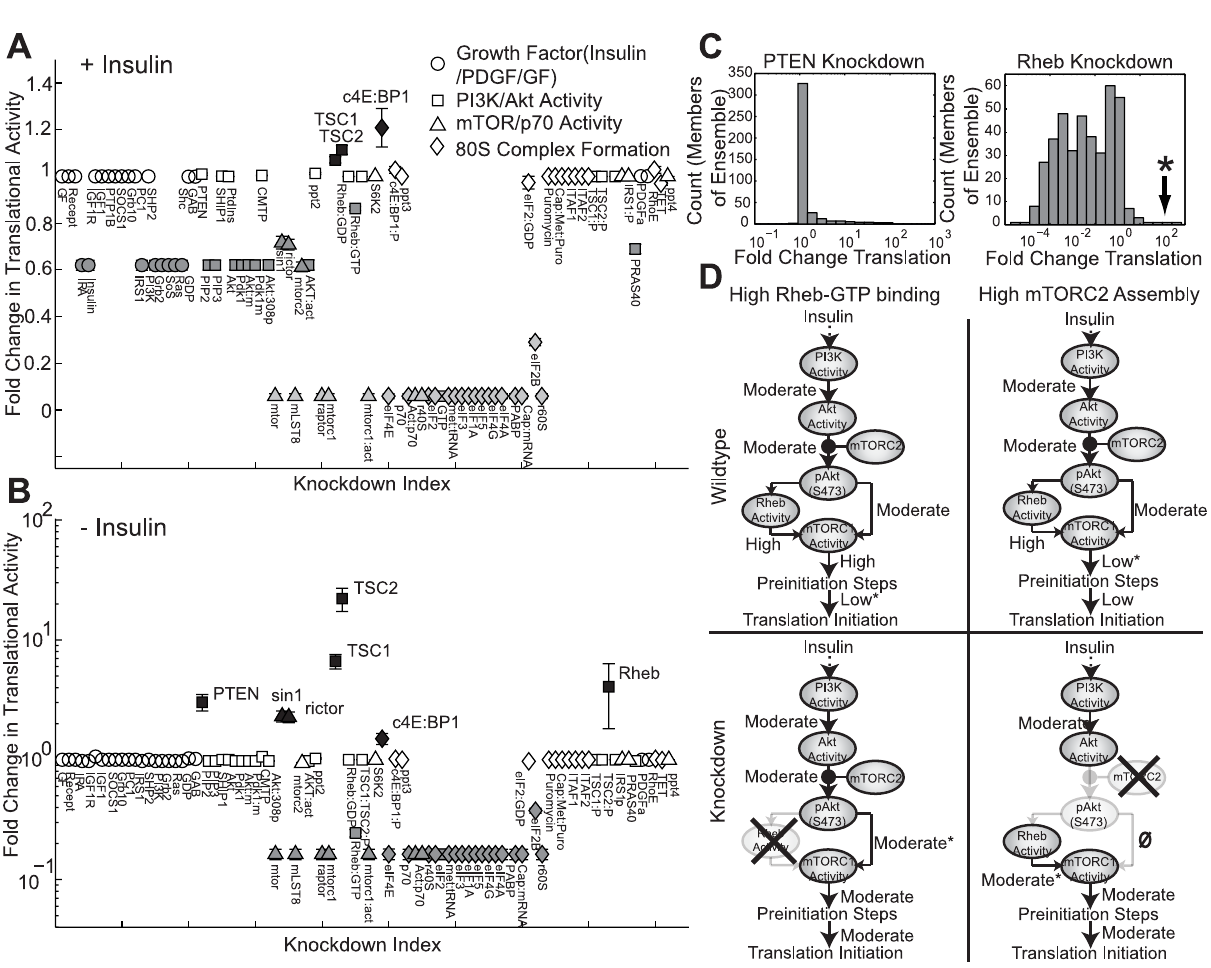
Figure 6. Species knockdown simulations for a population of translation initiation models (N=400). Simulated knockdowns were performed by removing nodes from the stoichiometric matrix. The relative change in 80S formation resulting from the removal of a species was used to quantify the impact of the knockdown. A. Species knockdowns in the presence of insulin. Simulated knockdowns resulted in increased (black), constant (white), moderately decreased (dark grey) or severely decreased (light grey) translational levels. B. Species knockouts in the absence of insulin. Simulated knockdowns resulted in increased (black), constant (white), or decreased (grey) translational levels. C. Histogram of translation levels across each member of parameter ensemble. Asterisk index indicates parameter sets that were selected for further analysis. D. Alternative modes of network operation. For a subset of the ensemble, initiation increased following Rheb or mTORC2 disruption. Asterisk indicates rate-limiting